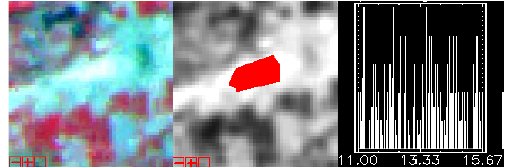
Fig.7 Man-made area mask after texture and spectrum extraction